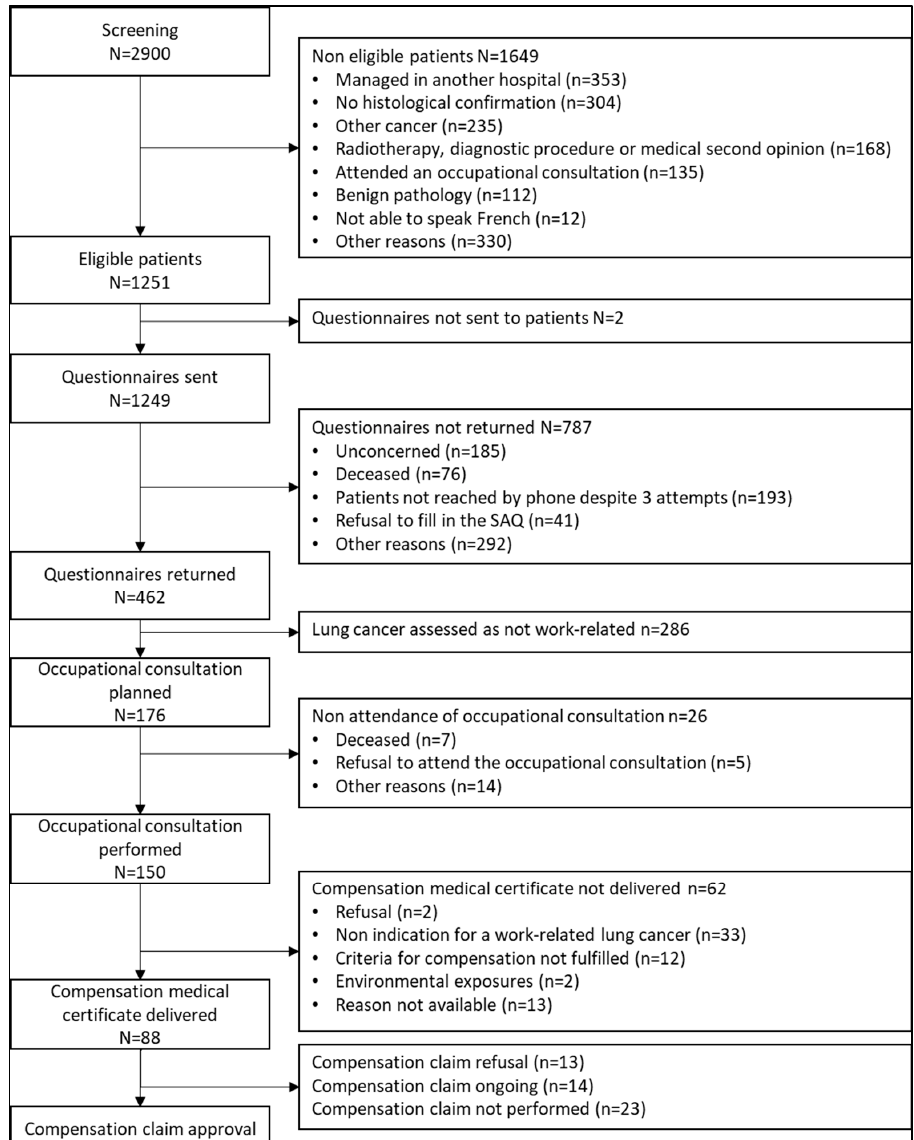
Figure 1. Study flowchart, 2017–2019, France.